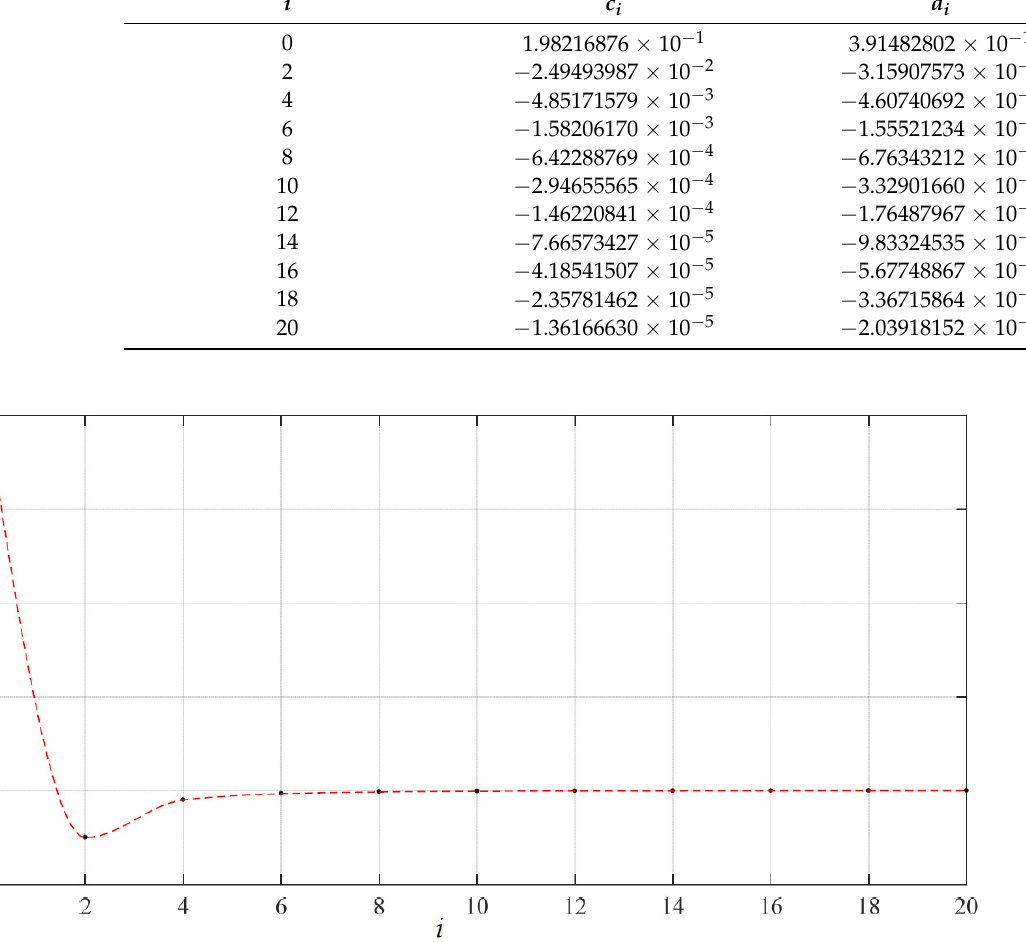
Figure 5. Variation of c i with i when c 0 = 1.98216876 × 10 − 1 , d 0 = 3.91482802 × 10 − 1 and H = 300 mm.